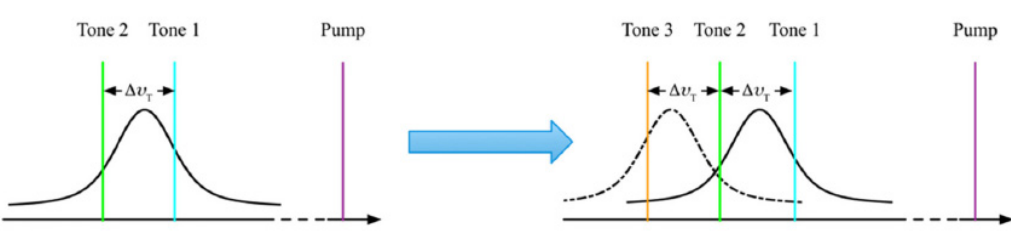
Figure 15. Extension of the measurement range by multi-slope-assisted BOTDA [62].